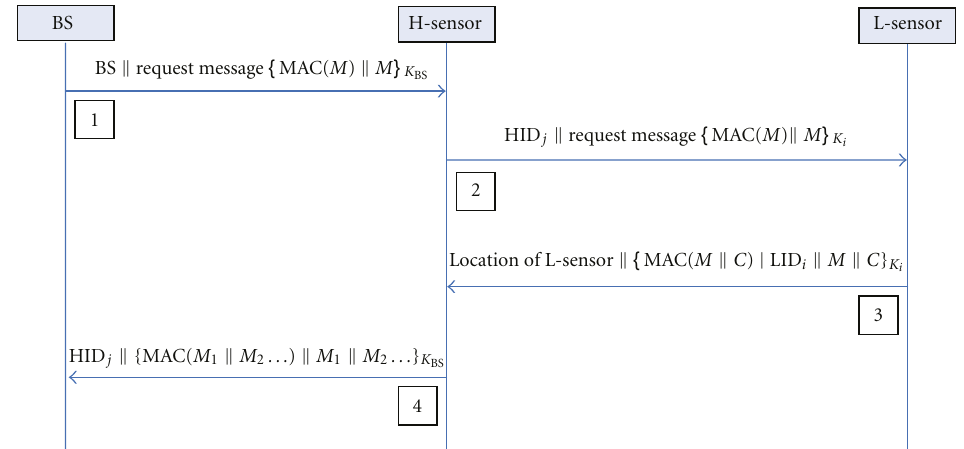
Figure 3: BS requires the data from the